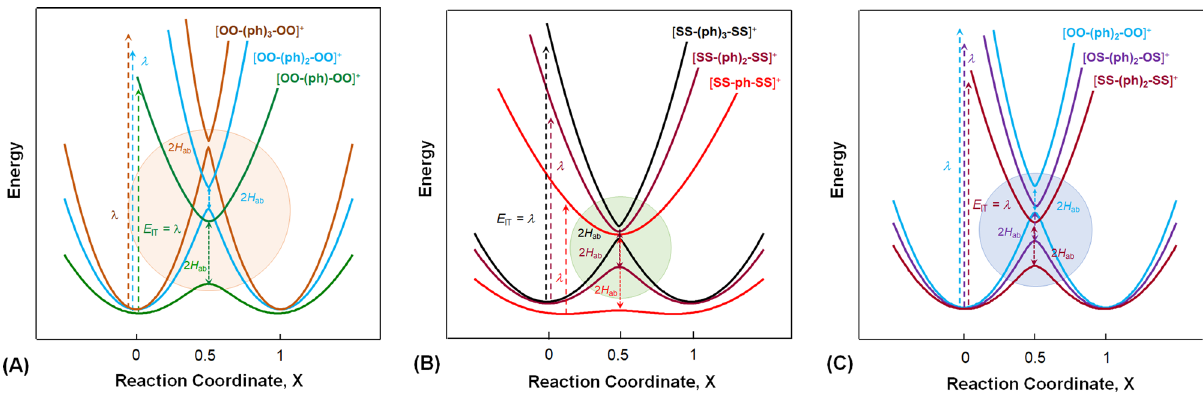
Fig. 4 Diagrams of the adiabatic potential energy surfaces for the mixed-valence {[Mo 2 ] – (ph) n – [Mo 2 ]} + derived from Eqs. (8) and (9) based on the optically determined λ and H ab . For each of the ET system, electronic coupling between the donor and acceptor generates the upper and lower PESs separated by 2 H ab . Vertical transition from the donor equilibrium state to the excited state of the acceptor, represented by a vertical arrow, takes place by absorbing the Frank – Condon energy ( E IT ), which equals numerically the reorganization energy ( λ ) in the Marcus theory. A Series [ OO – (ph) n – OO ] + ( n